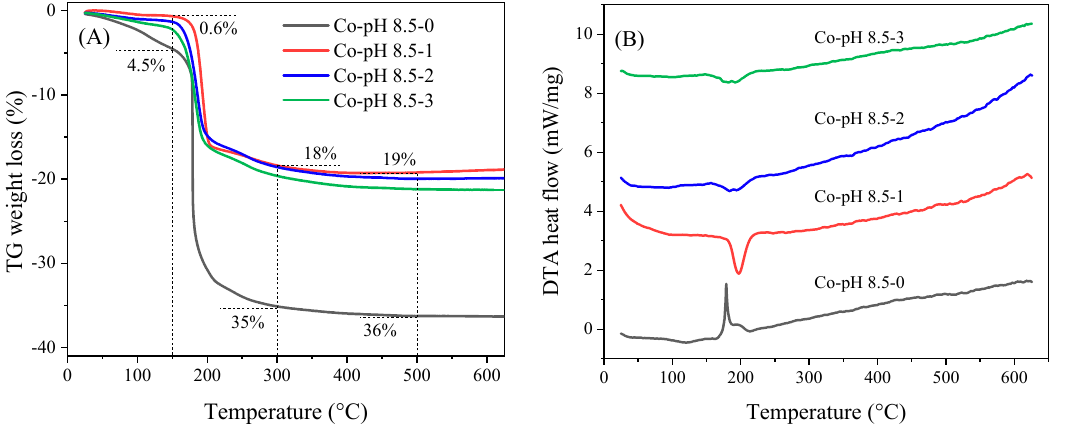
Figure 6. ( A ) TG and ( B ) DTA curves of cobalt precursors prepared at pH 8.5 with different number of washings.